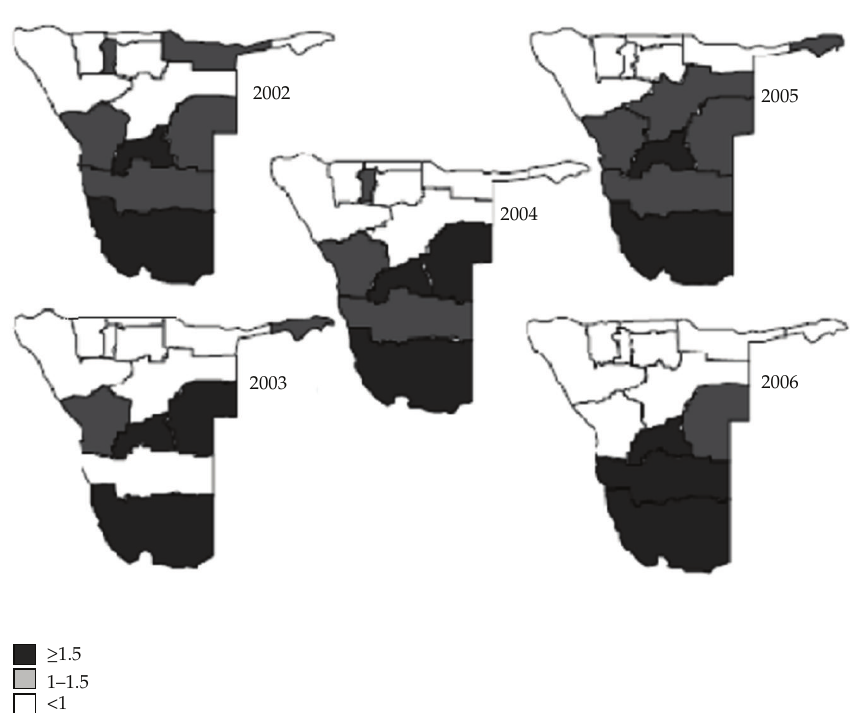
Figure 4: Crime maps of the posterior mean estimates of the relative risk (cid:5) λ rt (cid:6) of